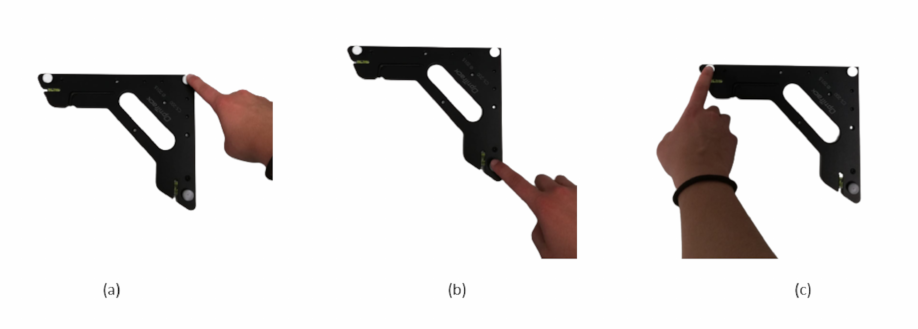
Figure 4. Referential definition on the HoloLens 2 application: ( a ) Step 1. ( b ) Step 2. ( c ) Step 3.